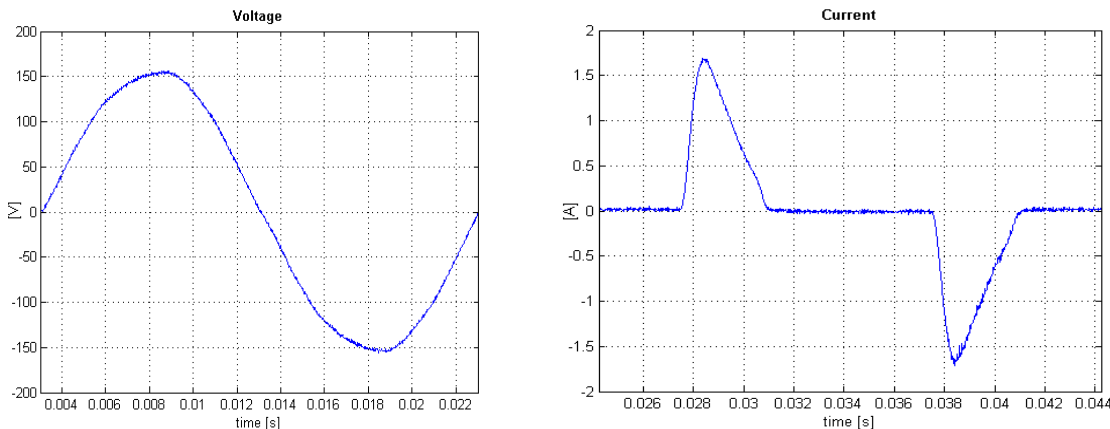
Figure 2. A period (20 ms) acquired at a sampling frequency of 80 kHz: ( left ) – voltage; ( right ) — current.